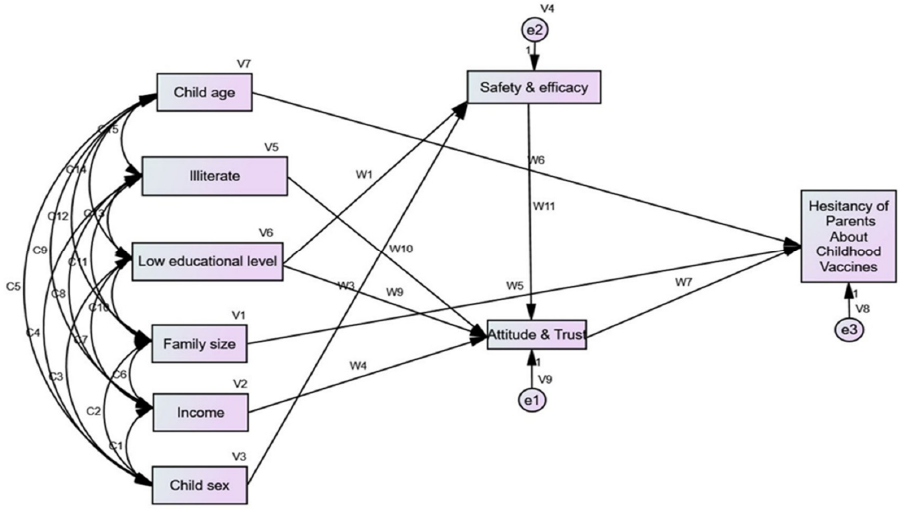
Figure 2. Visualization of the structural equations model for Hesitancy of Parents about Childhood Vaccines.